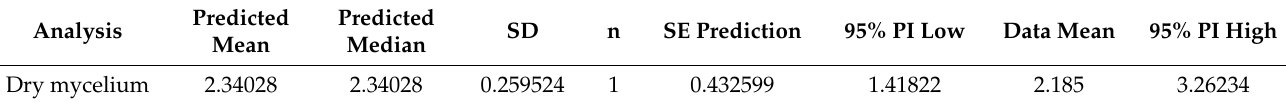
Table 6. Point prediction and confirmation of the dry mycelium response.